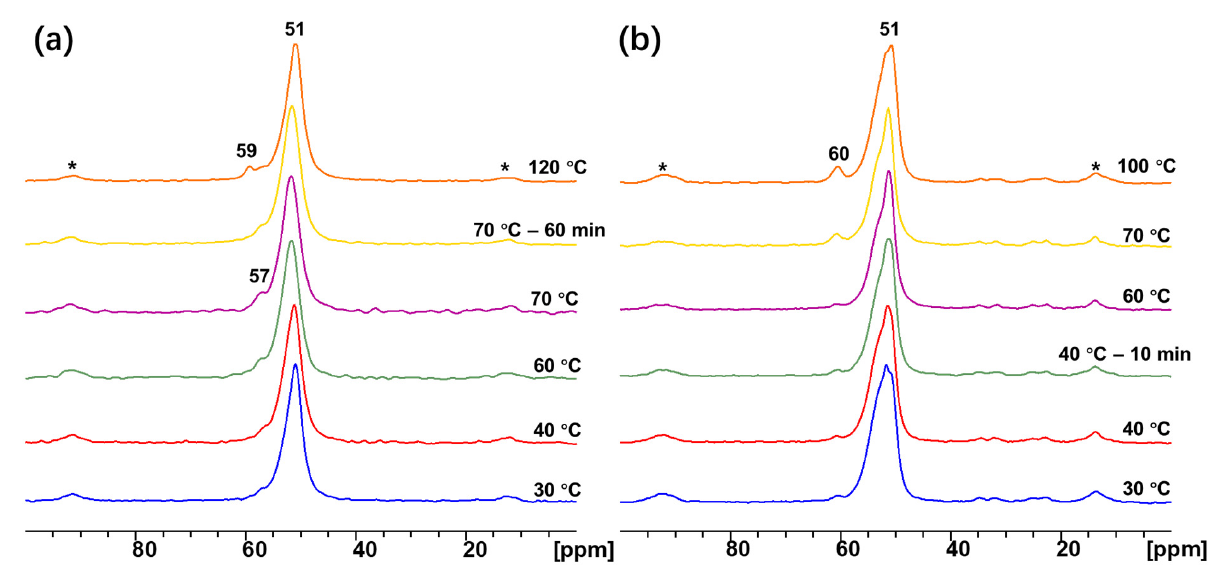
Figure 9. In-situ 13 C CP/MAS NMR study of methanol dehydration ( a ) without adding methyl n -hexanoate on H-ZSM-5 SAR23 at elevated temperatures; ( b ) with methyl n -hexanoate addition on H-ZSM-5 SAR23 at elevated temperatures. * Denotes spinning sidebands.